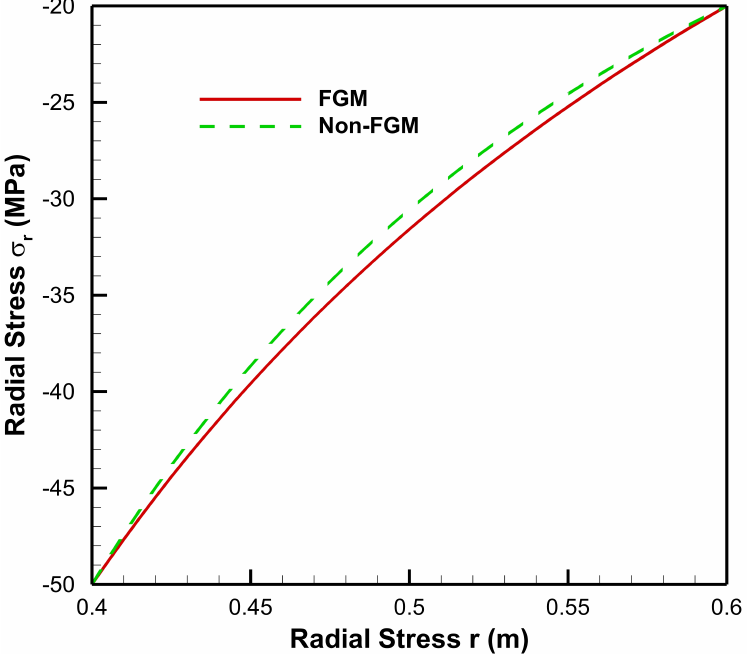
Figure 10. Radial Stress along the radius of the cylinder under internal pressure, P a = 50 MPa and external pressure, P b = 20